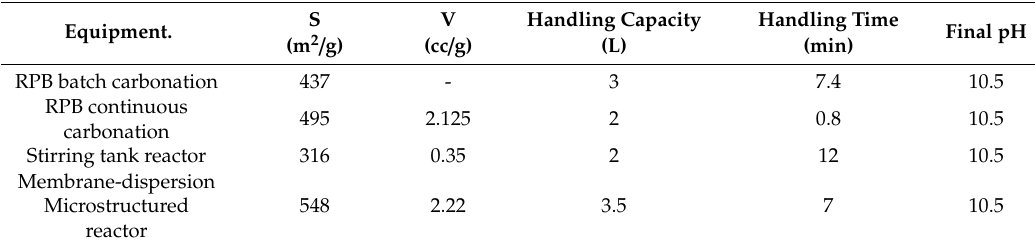
Table 6. Comparison of di ff erent methods for preparing